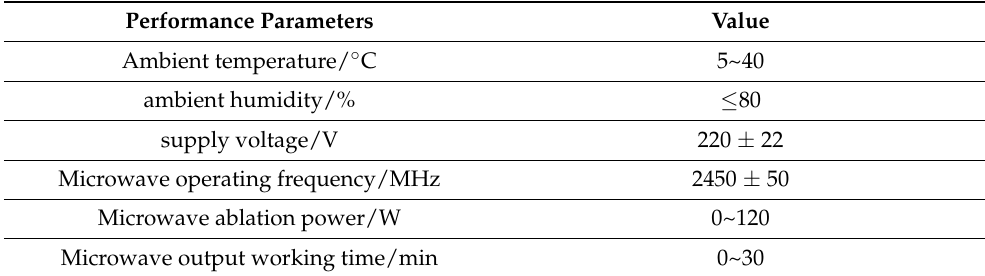
Table 1. Performance parameters of microwave ablation